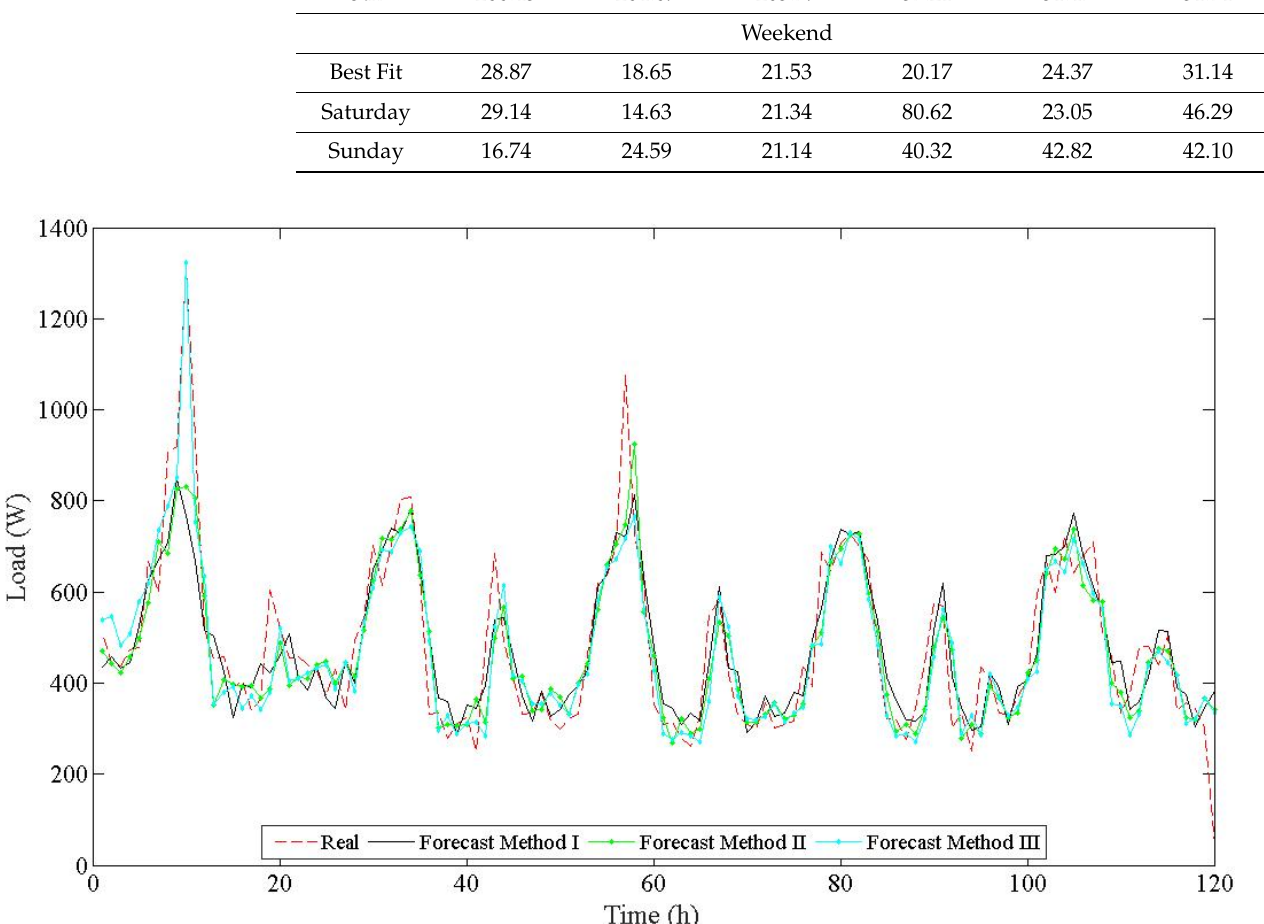
Figure 11. Forecast hourly load of working days of household No 85.